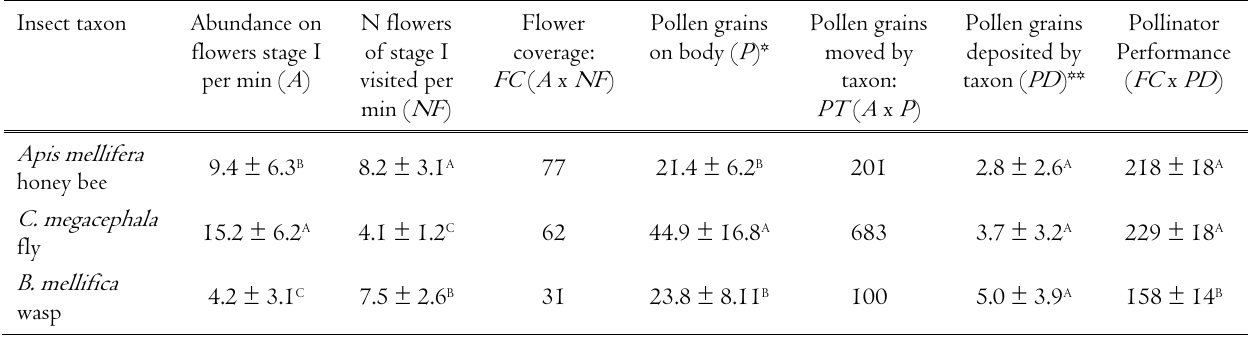
Table 2. Pollinator behaviour and performance of non-native bees ( Apis mellifera ), flies ( Chrysomya megacephala ) and native wasps ( Brachigastra mellifica ) visiting avocado